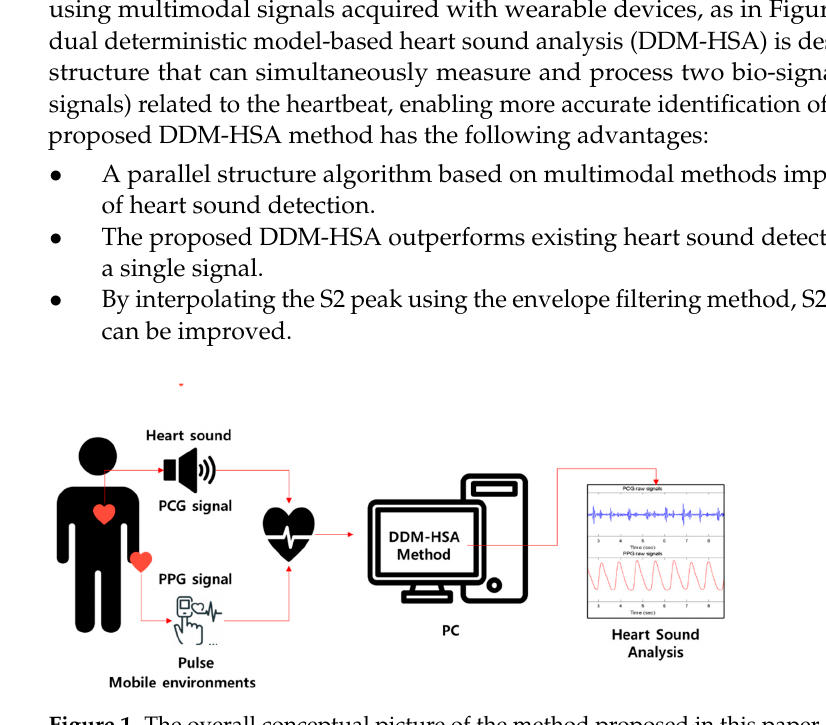
Figure 1. The overall conceptual picture of the method proposed in this paper.